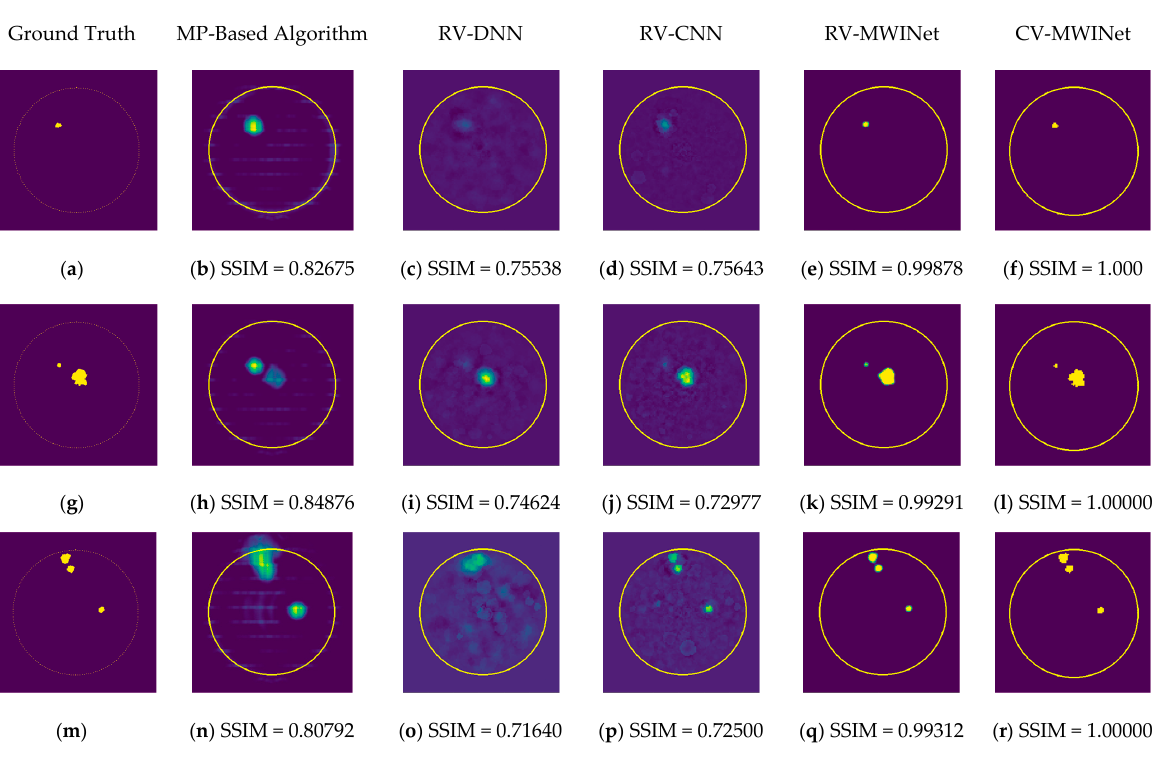
Figure 10. Accuracy curves for training and validation phases of the proposed CV-MWINet model. During the training of the CV-MWINet model, the complex average cross-entropy (CACE) loss function as given by Equation (29) was utilized, and the model weights at the iteration with the effective weight distribution were kept.